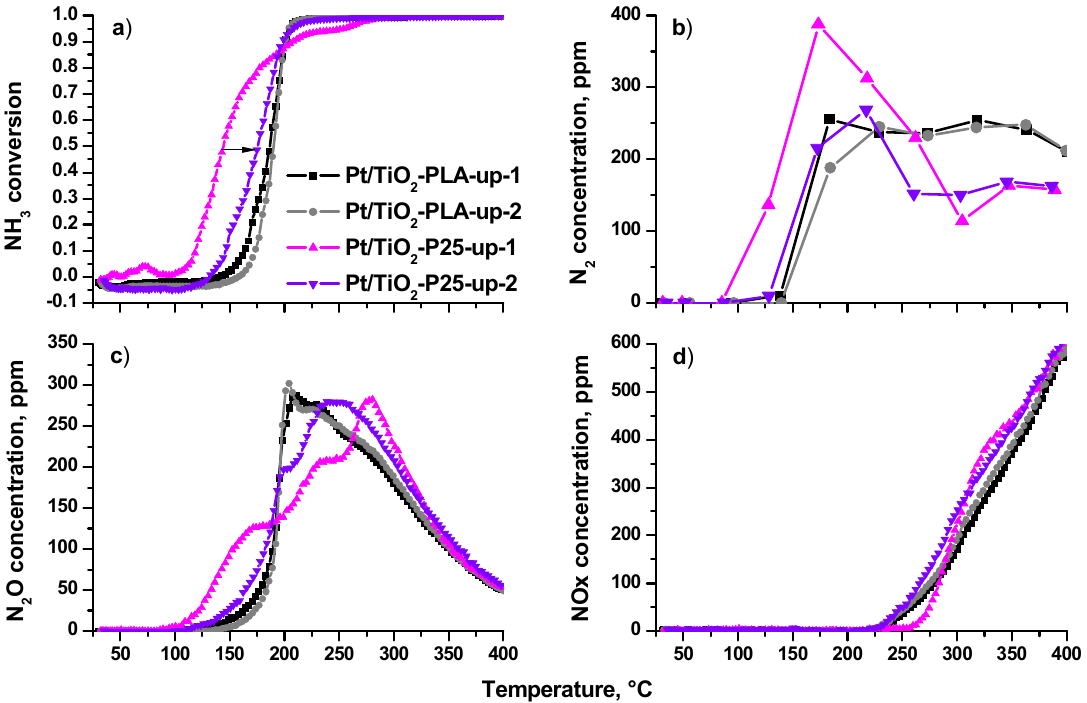
Figure10. ( a )NH 3 conversion; ( b )N 2 concentration, ( c )N 2 Oconcentrationand( d )NO x concentrationin Figure 10. ( a ) NH 3 conversion; ( b ) N 2 concentration, ( c ) N 2 O concentration and (d) NO x concentration reactorasfunctionofthetemperatureforPt / Ti-PLA-400andPt / Ti-P25-400catalystsintwocatalyticcycles in reactor as function of the temperature for Pt/Ti-PLA-400 and Pt/Ti-P25-400 catalysts in two catalytic (up-1—first sample heating in the reaction medium; up-2—the second heating in the reaction